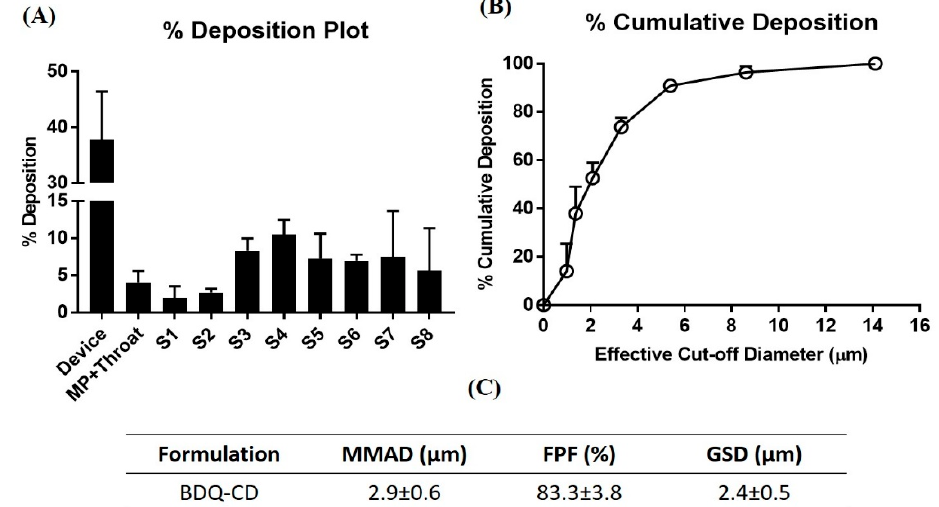
Figure 8. In vitro aerodynamic performance of BDQ-CD. ( A ) In vitro aerodynamic deposition of BDQ-CD in Next-Generation Impactor TM (NGI) stages ( B ) % cumulative deposition of BDQ-CD in NGI. ( C ) Aerosolization properties of BDQ-CD complex. Data represent mean ± SD ( n = 3).